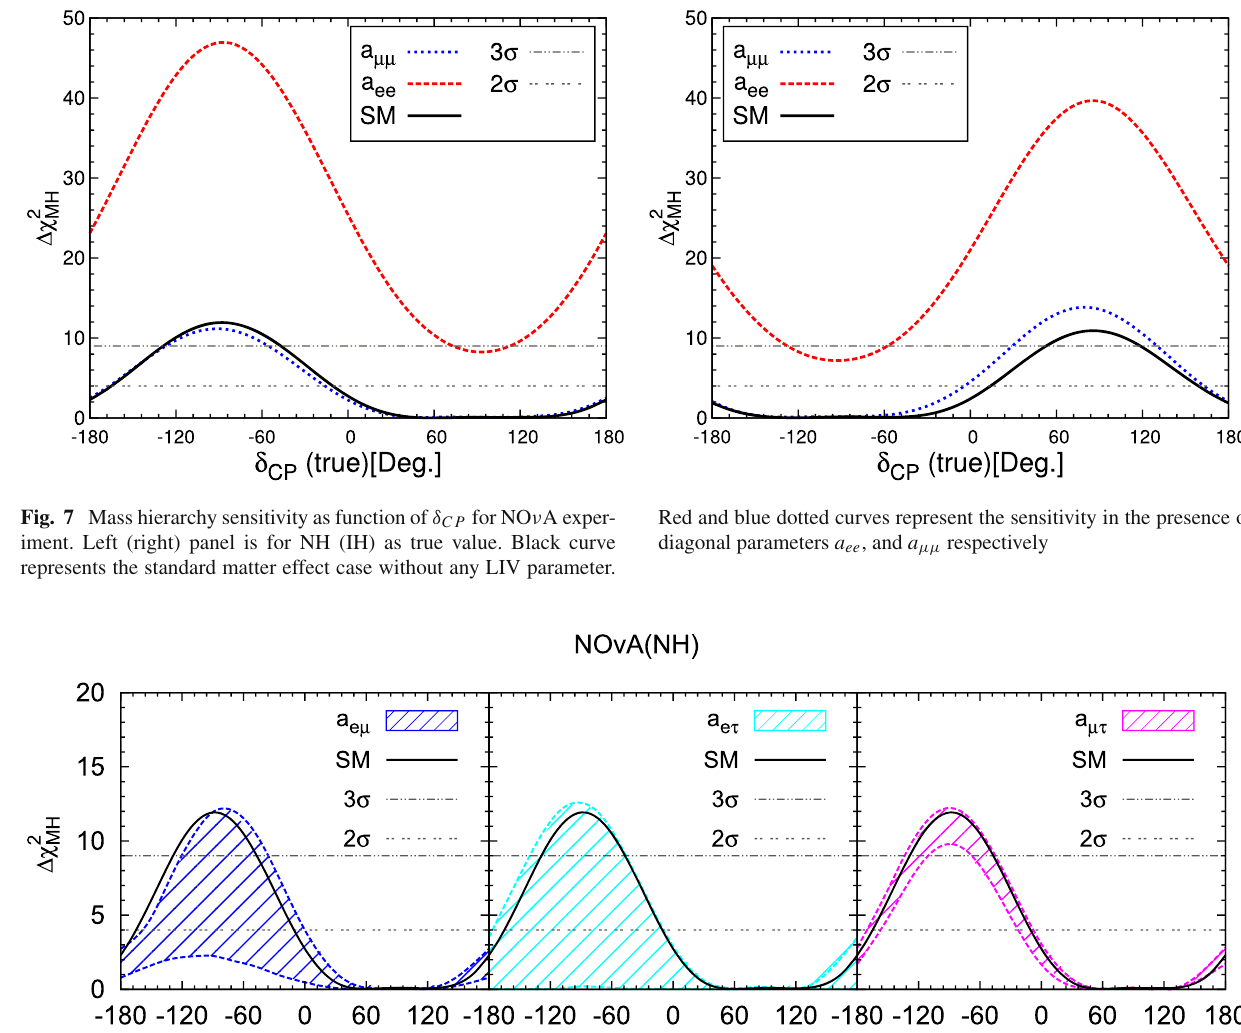
Fig. 8 Mass hierarchy sensitivity as a function of δ CP for NO ν A experiment in presence of a αβ . Black curve represents the standard matter effect case without any LIV parameter. Left, middle and right panels represent the sensitivity in presence of non-diagonal parameters a e μ , a e τ and a μτ respectively